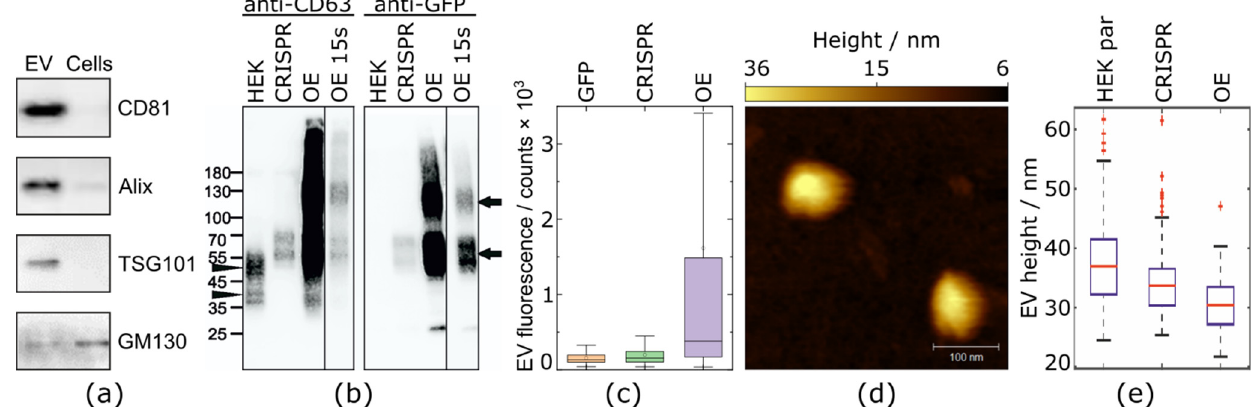
Figure 2. The characterization of extracellular vesicles and the expression of GFP-CD63. The EVs were enriched from either parental HEK293T cells or cells that were stably expressing GFP-CD63— achieved either by CRISPR/Cas9 (CRISPR-EV) or a conventional over-expression system (OE-EV). ( a ) Small EVs that were isolated from CRISPR GFP-CD63 stable cell lines were compared to total cell lysates by Western blotting of positive marker proteins for EVs (CD81, Alix, TSG101) and the negative marker GM130. ( b ) Comparison of EVs from parental HEK293T cells, CRISPR-EVs, and OE-EVs. Equal amounts (5 µg) of total protein were loaded and the membrane was probed either with an anti-CD63 antibody or an anti-GFP antibody. The bands for endogenous CD63 (arrowheads, left side) and for the GFP-CD63 fusion proteins (arrows, right side) are indicated. A 15-second short- time exposure of the OE-samples was added to enable a comparison of the band sizes to the other samples. ( c ) Recombinant GFP protein, CRISPR-EVs, and OE-EVs were immobilized on Poly-D- Lysine (PDL)-coated glass cover slips. The intensity profiles of the fluorescent spots were fit with a Gaussian function and the corresponding distribution fits of the integrated intensities are shown as box plots. ( d ) HS-AFM image of isolated EVs, exemplarily shown for CRISPR-EVs. The color bar expresses the height of the vesicles in nm. ( e ) HS-AFM analysis EVs of parental HEK293T, CRISPR- EVs, and OE-EVs. The particle height was measured as described in the Materials & Methods. Ap- proximately 70 measurements per sample are depicted in the box plot, the median is indicated by the red line.